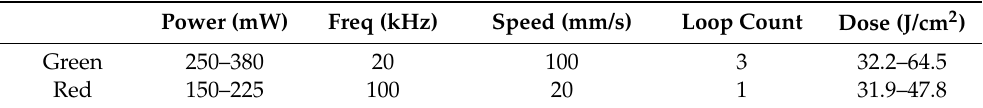
Table 5. Summary of the laser parameters used to obtain areas emitting selectively green or red during direct laser writing process.